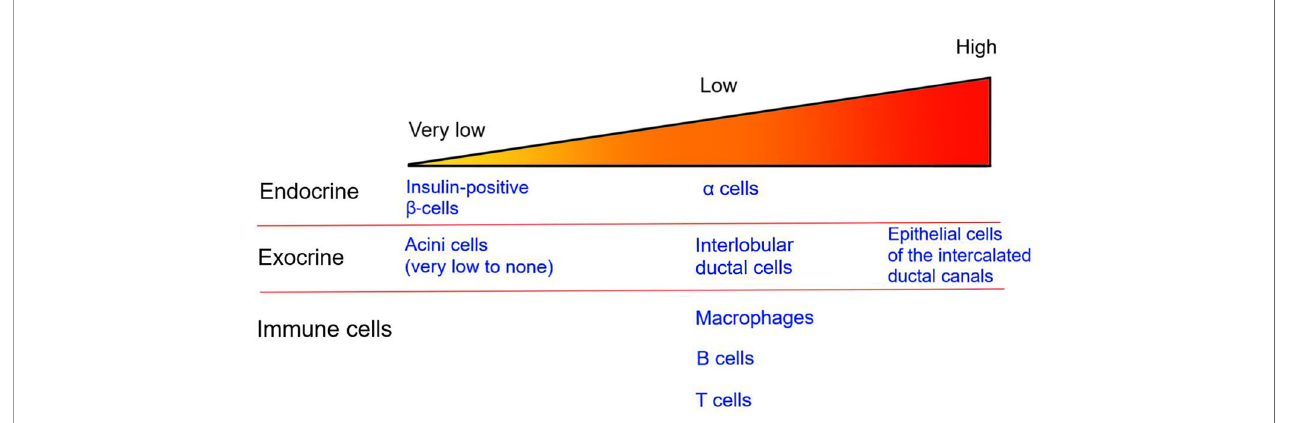
FIGURE 1 | CFTR expression in the pancreas. The image represents the relative level of CFTR expression in pancreatic endocrine and exocrine tissues as well as in immune cells. Speci fi c cell types are